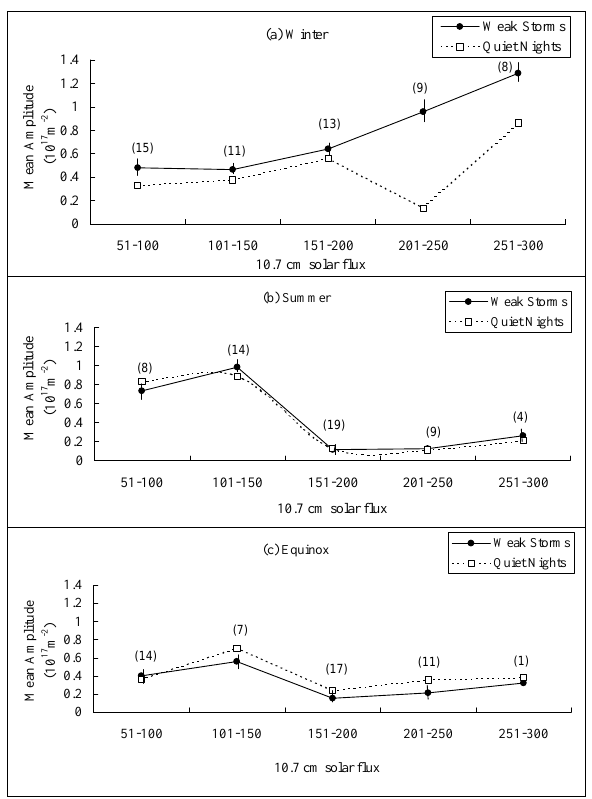
Fig. 2. The seasonal and solar activity variations of mean amplitude during weak storms (solid curves) and quiet nights (dashed curves). The numbers of weak storms are given in brackets beside the points for each solar flux group. The vertical bars represent the standard